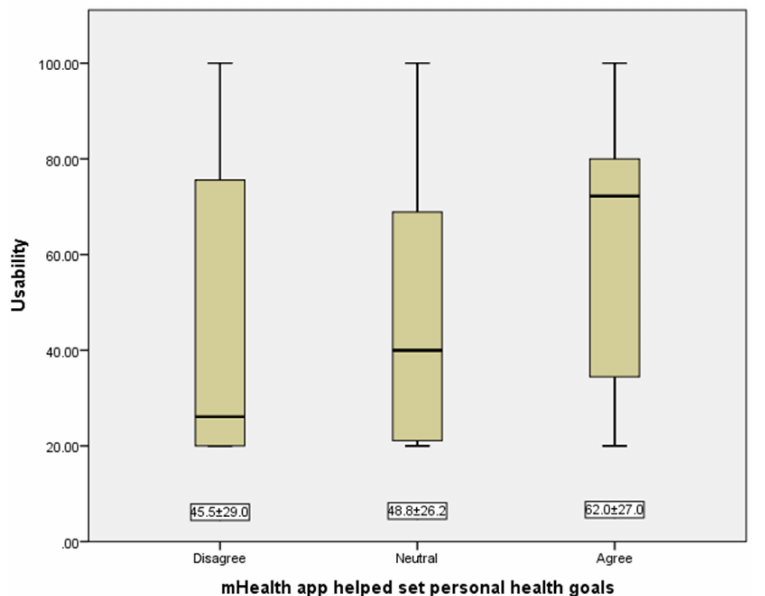
Figure 5. The association between usability scores and setting personal health goals among mHealth app users. Using one-way ANOVA with the Bonferroni post hoc correction, the p -values were as follows: disagree vs. neutral = 0.999, neutral vs. agree = 0.230, and disagree vs. agree =